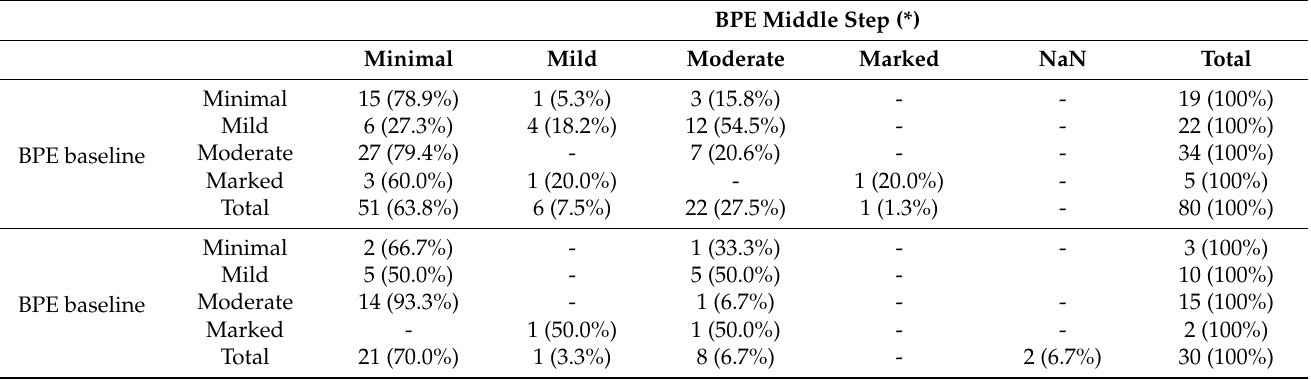
Table 4. Absolute frequency distribution (percentage) of BPE in the three resonance steps of patients undergoing